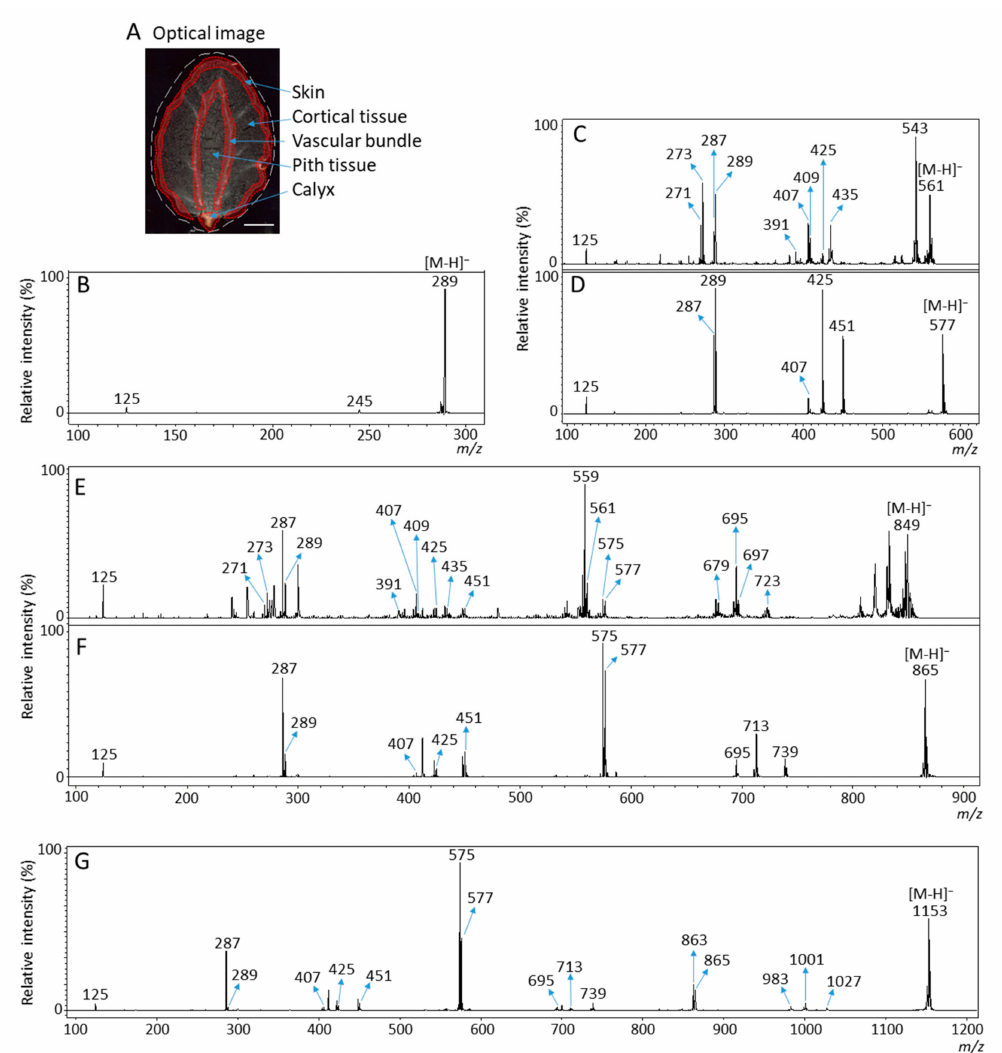
Figure 3. Matrix-assisted laser desorption / ionization (MALDI)-tandem mass spectrometry (MS / MS) analysis of strawberry fruit sections. MALDI-MS / MS spectra were obtained from in the calyx, in and around the vascular bundles, and in the skin of strawberry fruit sections after MALDI-mass spectrometry imaging. ( A ) Optical image of a strawberry fruit section. The dotted red line shows the analyzed region. Scale bar = 5 mm. Representative MS / MS spectra of precursor [M − H] − ions at m / z ( B ) 289.1, ( C ) 561.1, ( D ) 577.1, ( E ) 849.2, ( F ) 865.2, and ( G ) 1153.3 obtained from a strawberry fruit section. The fragment ion peaks with m / z values were used for molecular